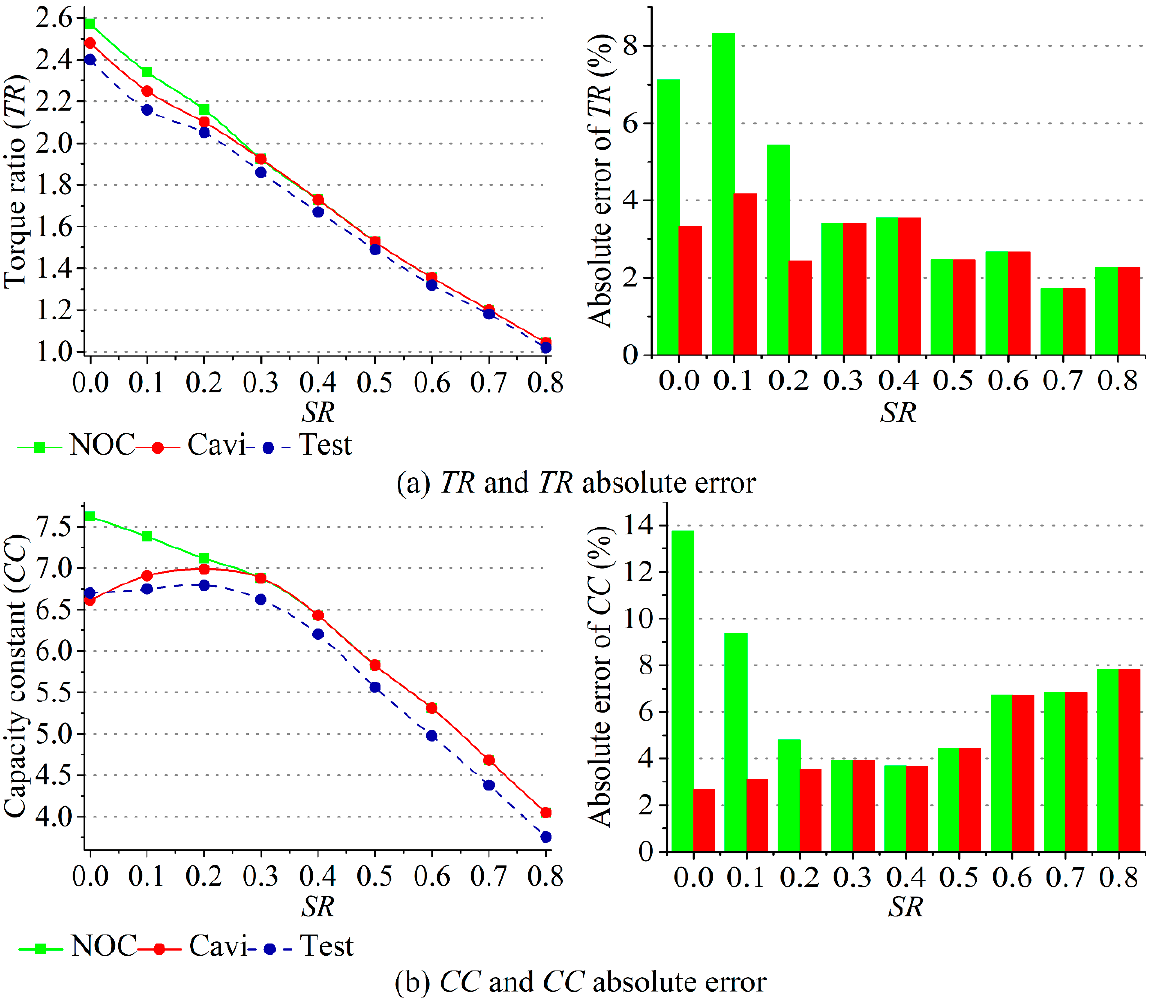
Figure 6. Comparison of computational fluid dynamics (CFD) results against test data under various operating